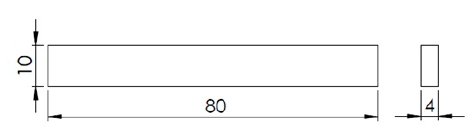
Figure 2. Test specimen’s geometry: 80 mm × 10 mm × 4 mm, according to the D6272-02 ASTM standard.